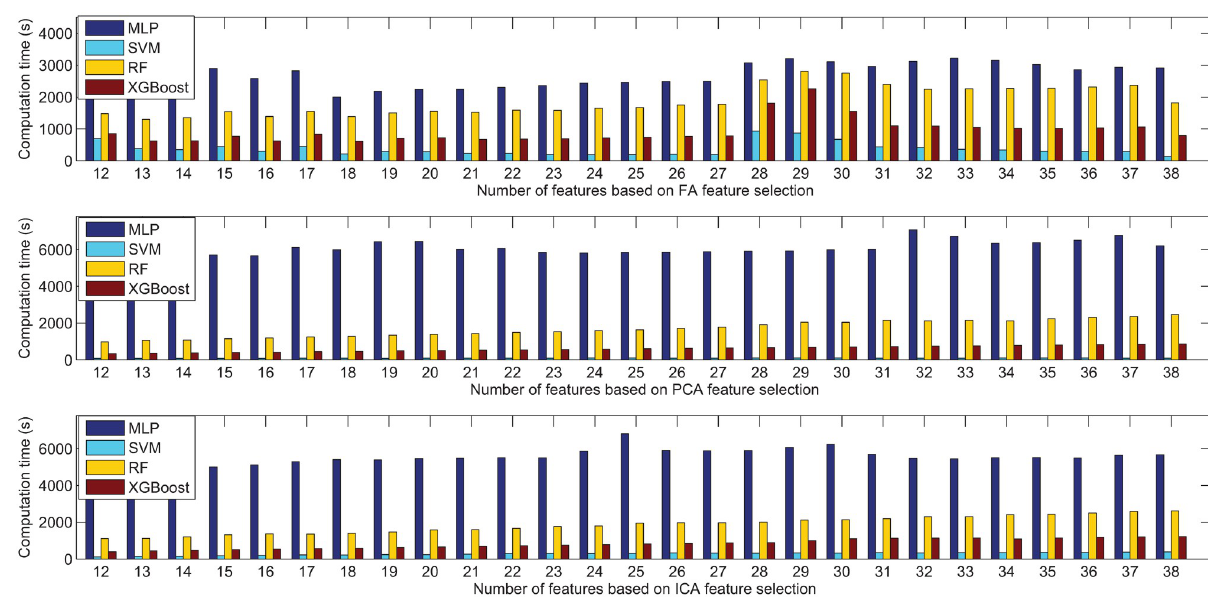
Fig 12. Comparison results in terms of computation time based on FA, PCA, and ICA feature extraction for the NHANES dataset.